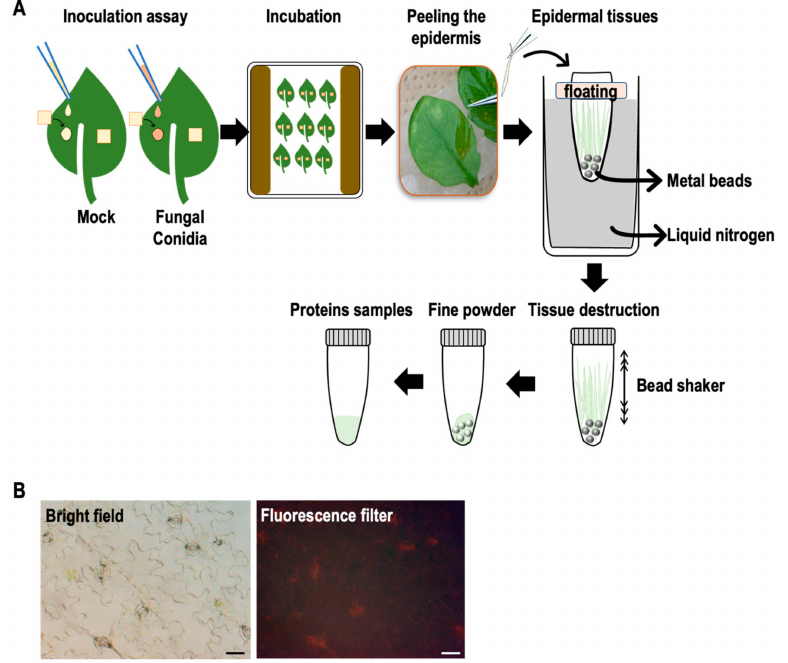
Figure 2. Illustration of leaf inoculation, epidermal peel preparation, and protein extraction. ( A ) The leaf epidermis was peeled rapidly within 3 min per leaf (inoculated and control) and